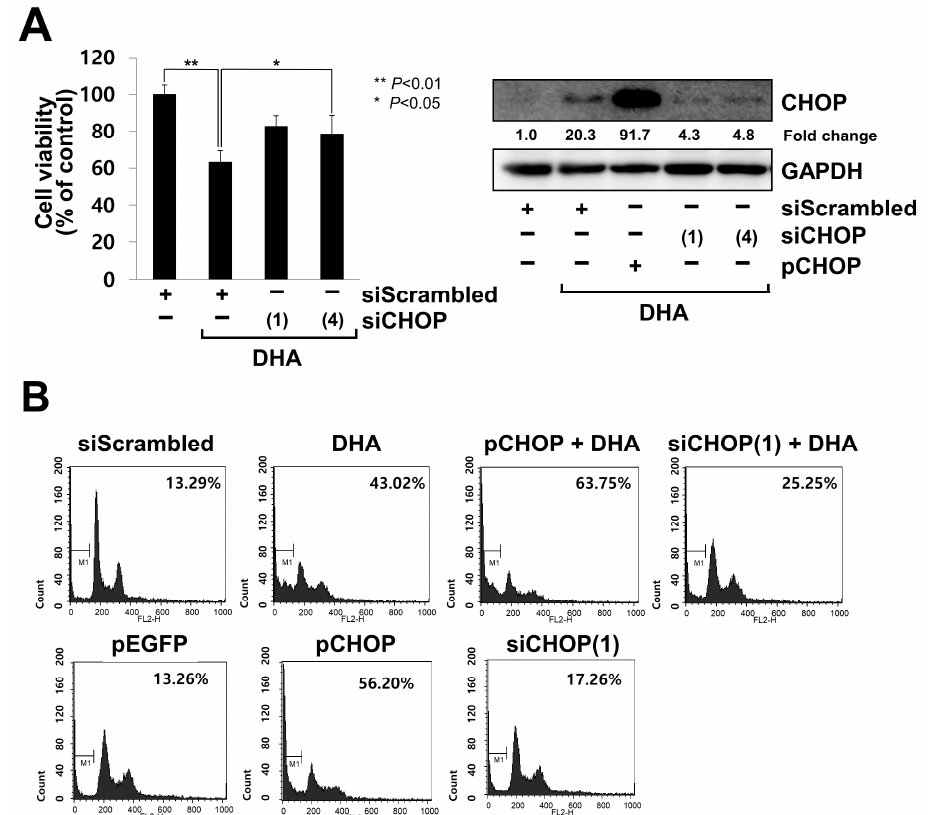
Figure 3. CHOP played a role as a pro-apoptotic factor in DHA-treated MH7A cells. The cells were transiently transfected with siRNA oligonucleotides specific for CHOP [siCHOP (1) or siCHOP(4)], scrambled oligonucleotides (siScrambled), a vector overexpressing CHOP (pCHOP), or EGFP (pEGFP). At 18 h post-transfection, the cells were treated with 130 μ M DHA for 24 h. ( A ) Cell viability was determined using the Ez-cytox assay (left). Significant differences are indicated as * p < 0.05 or ** p < 0.01. Cell lysates were subjected to SDS-PAGE, followed by immunoblot analysis using antibodies specific to CHOP or GAPDH (right). Blots have been cropped down to size for clarity. ( B ) Cells were subjected to FACS analysis with PI staining. Apoptosis is expressed as the percentage of cells counted in the sub-G1 phase, as indicated by the bar in the histogram.